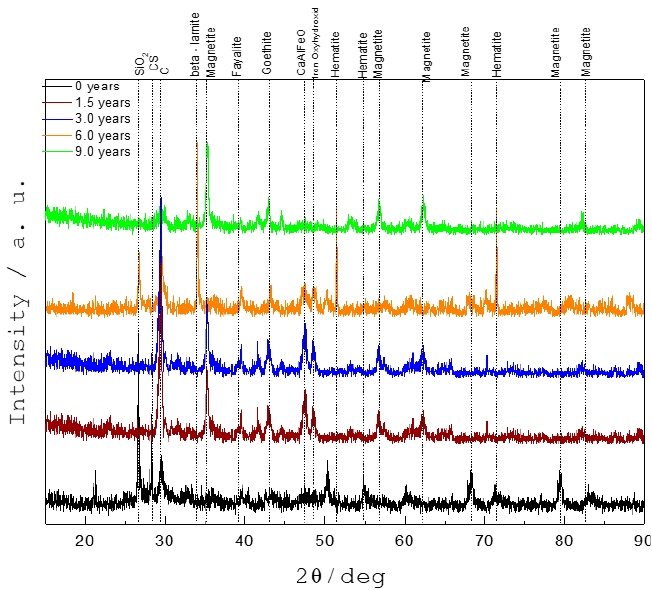
Figure 9. The X-ray diffraction patterns of the concrete–steel interface.